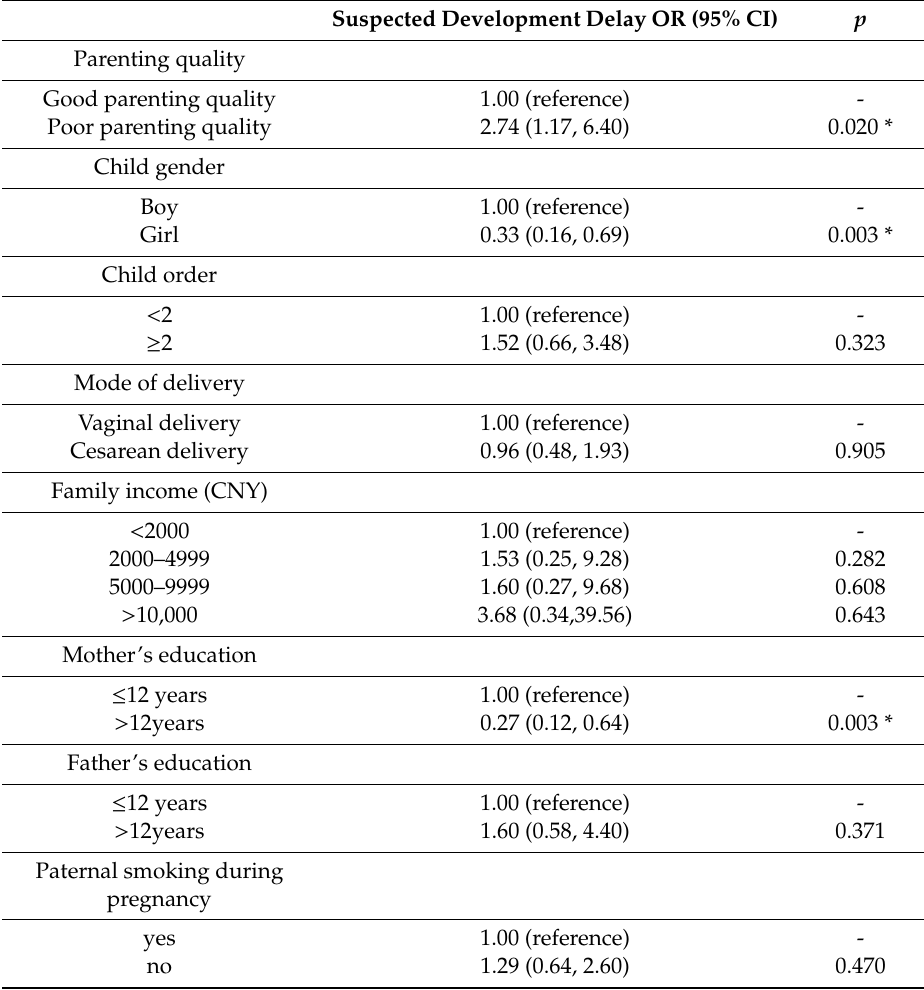
Table 3. Factors a ff ecting suspected development